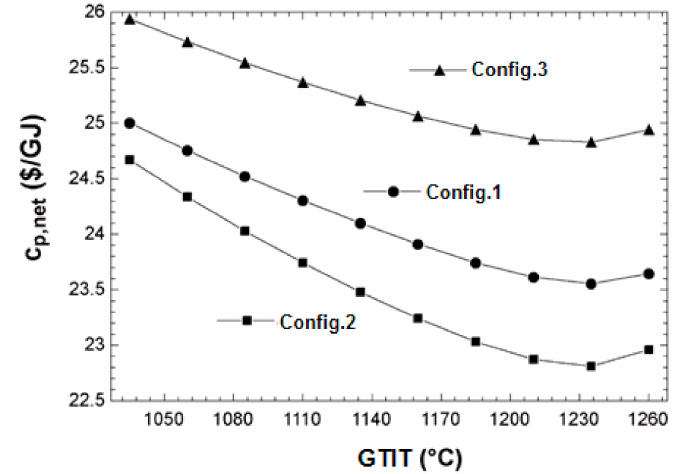
Figure 13. Effect of gas turbine inlet temperature change on the exergy unit cost of produced